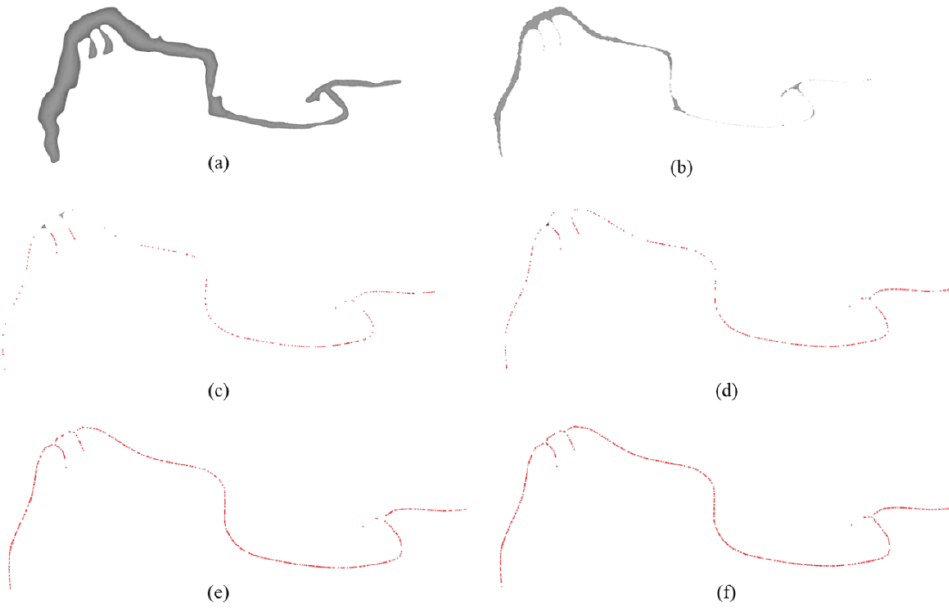
Figure 5. Three-dimensional skeleton extraction: ( a ) reconstructed 3D model; ( b ) the first iteration shrinkage; ( c ) the third iteration contraction; ( d ) the fifth iteration contraction; ( e ) the nth iteration contraction; ( f ) the three-dimensional skeleton.